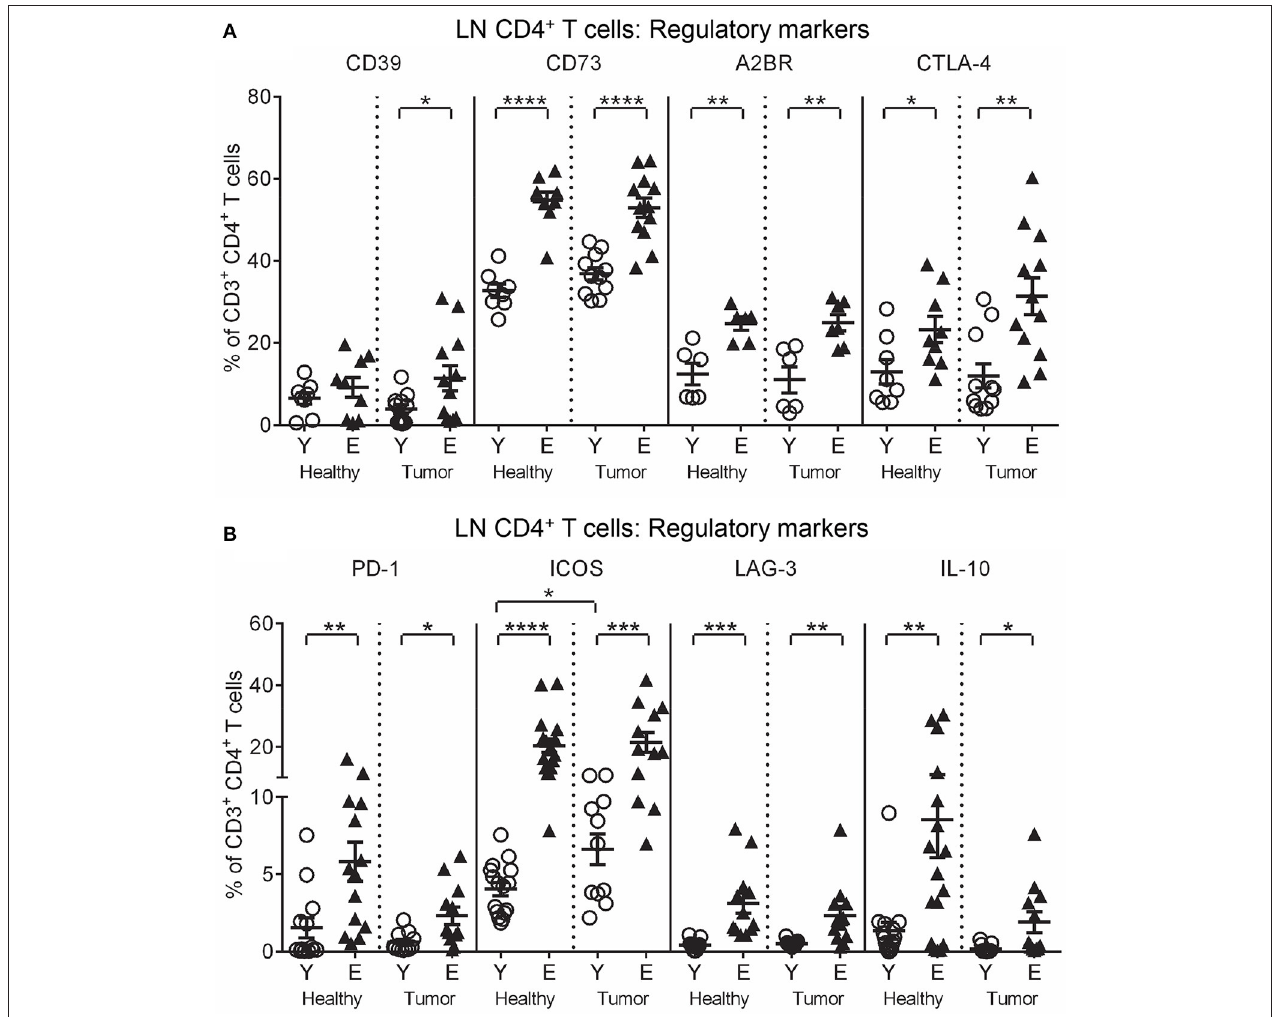
FIGURE 2 | Increased regulatory markers on elderly LN/TDLN CD4 + T cells. Percentages of CD4 + T cells positive for regulatory markers were measured in TDLNs from the same mice shown in Figures 1A–D young and elderly tumor-bearing mice, and LNs from age-matched healthy young and elderly mice (A,B) , via flow cytometry. Data are shown for individual mice as well as as mean ± SEM, n = 6–11 young and n = 7–12 elderly tumor-bearing mice, n = 6–17 young and n = 6–17 elderly healthy mice, * p < 0.05, ** p < 0.005, *** p < 0.0005, **** p < 0.0001 comparing (i) young to elderly mice, or (ii) tumor-bearing mice to age-matched healthy